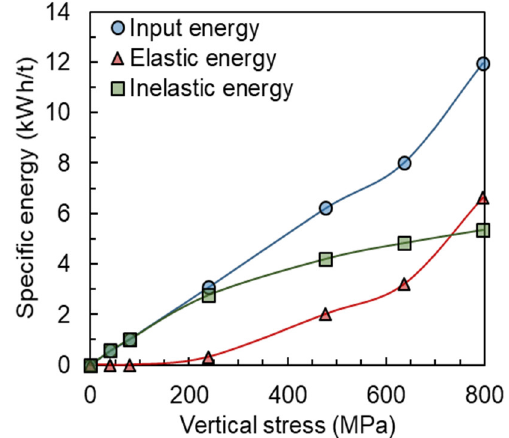
Figure 4. Variation of the input, elastic, and dissipated energy in the particle bed as a function of vertical stress for the Itabira sample for the narrow size range of 150–125 µm.